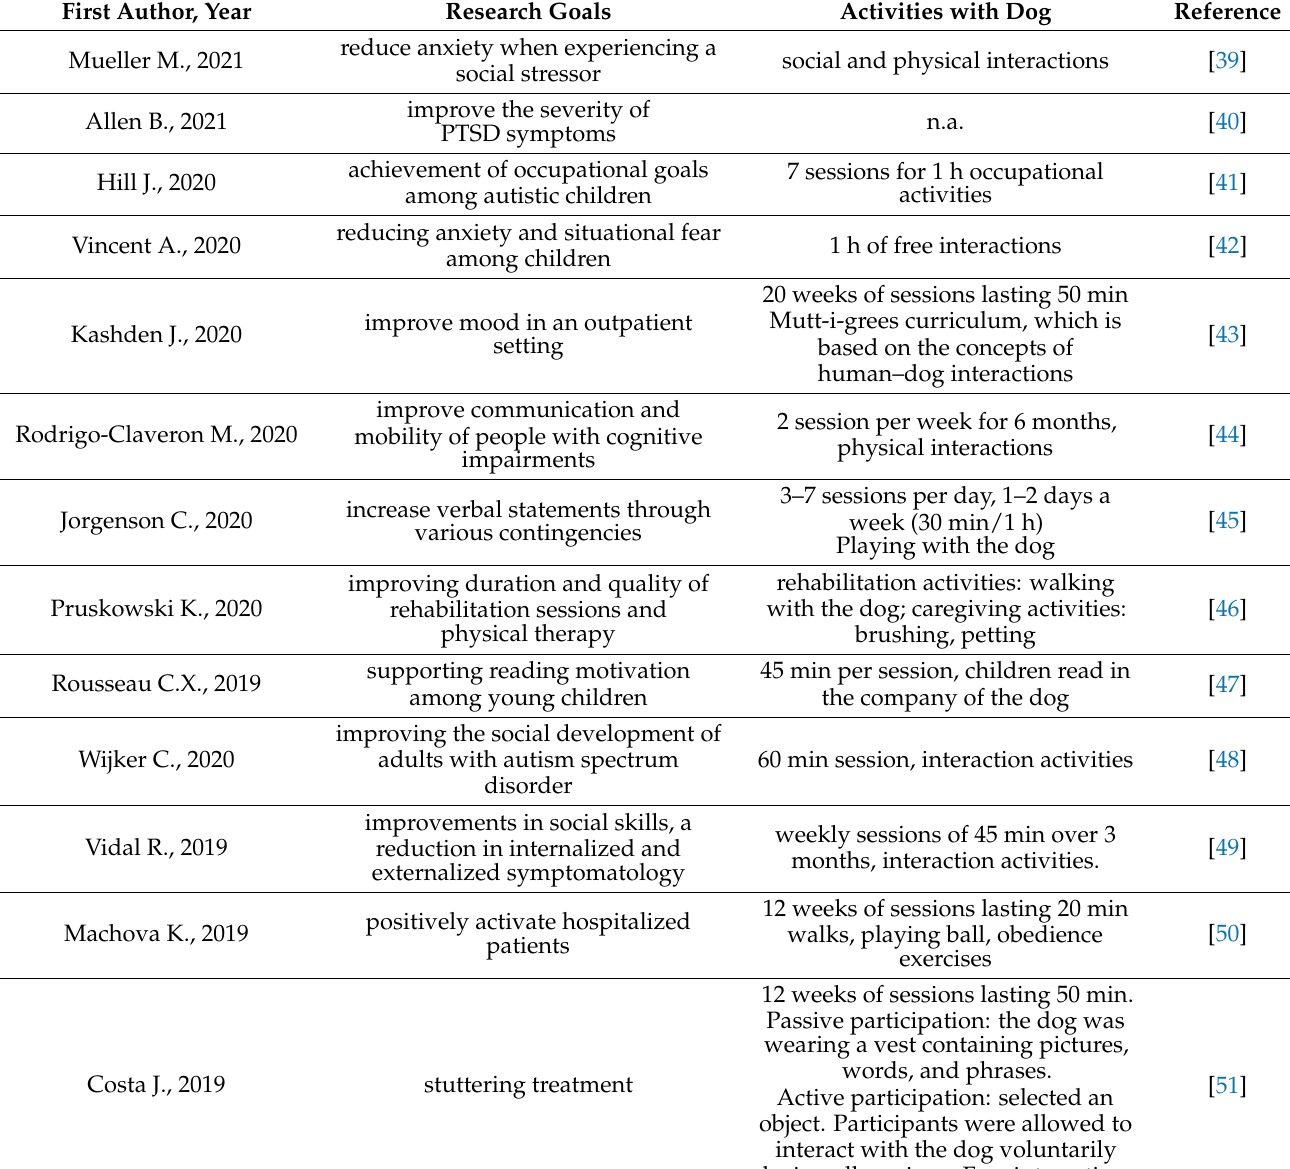
Table 2. Results of information on the “research goals” and “activities with the dog” in the included